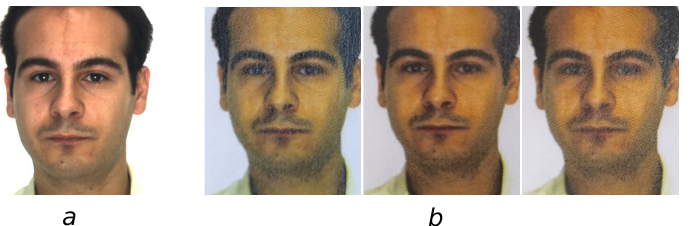
Figure 5. Example images from the Print-Capture AR dataset: ( a ) original digital image; and ( b ) captured photo